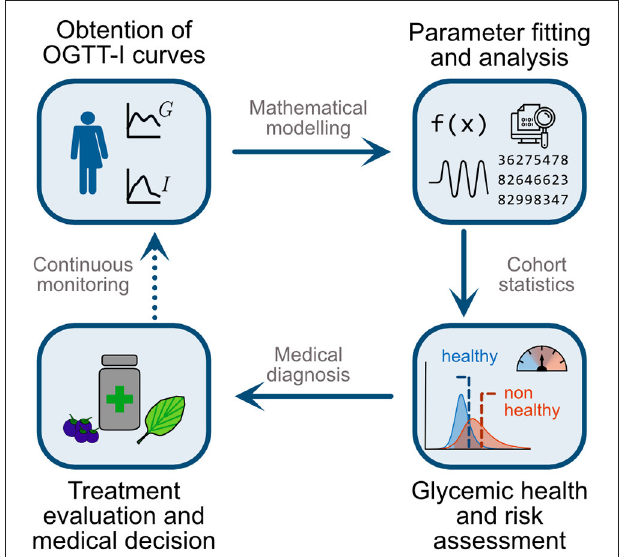
FIGURE 2 | Schematic representation of the proposed methodology for a patient-wise assessment of nutritional and general interventions to reduce dysglycemia risk. First, individuals undergo an OGTT with five measurements for glycemia and insulinemia (5-point OGTT-I). Second, use the mathematical model and parameter fitting strategy of Contreras et al. (23) to obtain physiologically meaningful indexes to assess both the function and coordination among subsystems. Third, contrast individual values with those obtained in a cohort study. Here we evaluate whether a patient belongs to the healthy or non-healthy ranges and her/his overall risk of progressing to dysglycemic states. Fourth, using this assessment, practitioners may select suitable treatments or interventions, such as polyphenol-rich diets or supplementation, for targeted alteration of particular physiological subsystems and parameters. Finally, repeating the OGTT-I and monitoring over time enables the assessment and dynamic adaptation of interventions, for example adjustment of diet and polyphenolic supplementation targeting different subsystems according to the individual patient’s